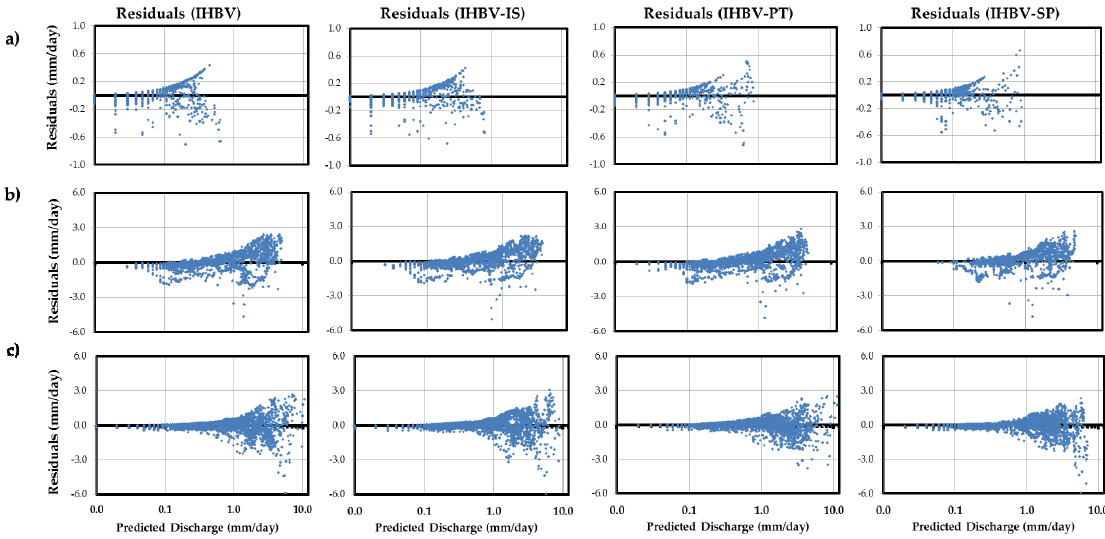
Figure 10. Scattergrams of residuals during test period: ( a ) Ajichai; ( b ) Lighvan; and ( c ) North Fork.